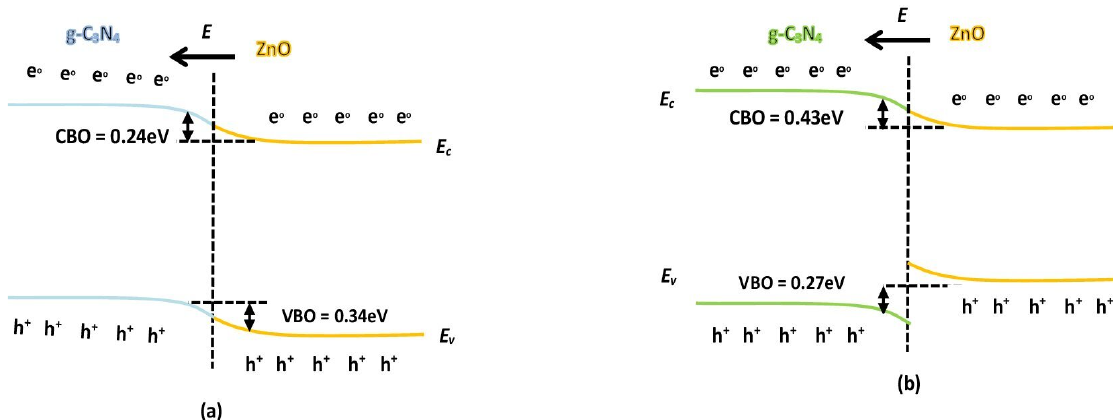
Figure 10. Schematic diagram revealing the photocatalytic mechanism of g-C 3 N 4 /ZnO catalyst: ( a ) conduction band of 0.24 ev and ( b ) conduction band of 0.43 eV.